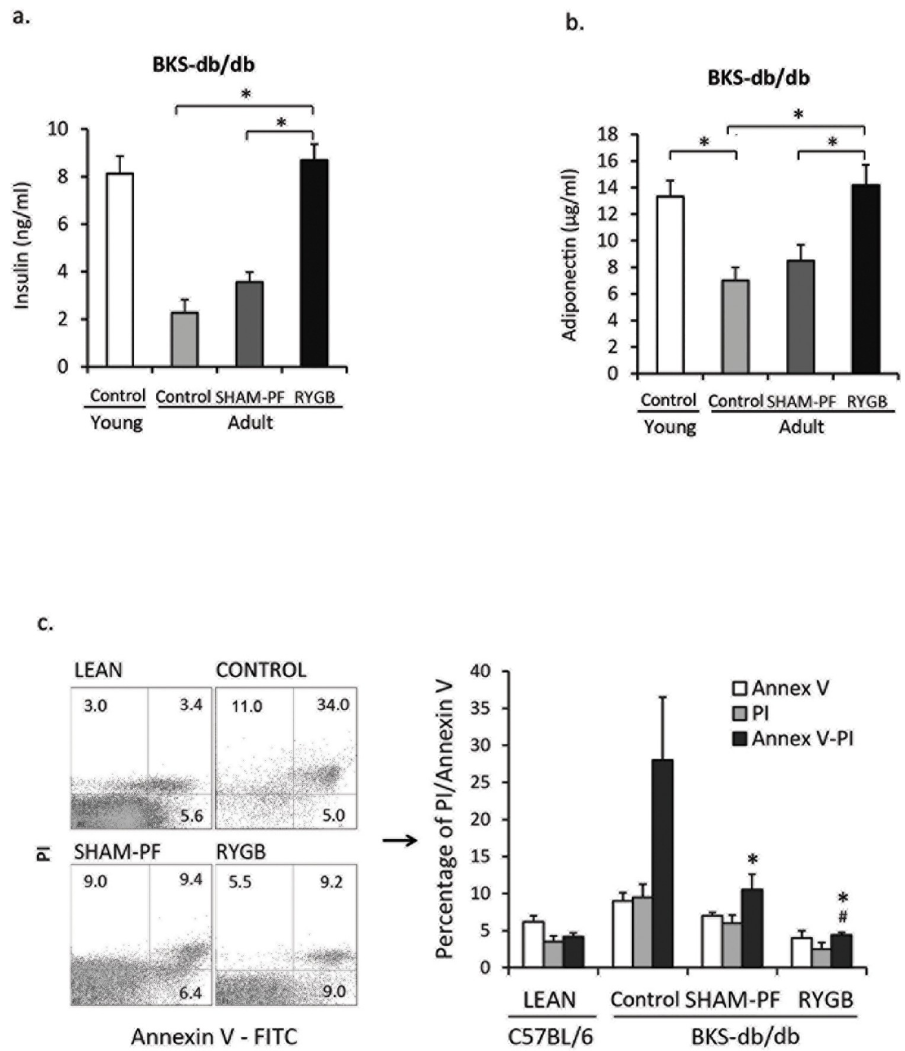
Fig 3. RYGB maintains circulating insulin and adiponectin levels, preserves β -cell mass and prevents β -cell apoptosis when performed in young prediabetic BKS-db/db mice. a. Circulating insulin levels. Young BKS-db/db mice (6 weeks old, n = 5); Adult BKS-db/db mice (12 weeks old, n = 5); SHAM-PF, sham surgery and pair-feeding (n = 5); and RYGB, BKS-db/db mice with RYGB at 6 weeks of age (N = 8). � : RYGB vs. SHAM-PF and Adult Control, p < 0.01. b. Circulating adiponectin levels. � : Young BKS-db/db vs. Adult BKS-db/db, and RYGB vs. SHAM-PF and Adult Control, p < 0.01. c. Annexin V flow cytometry analysis of apoptotic β -cells. LEAN, C57BL/6 mice; CONTROL adult BKS-db/db mice; SHAM-PF, BKS-db/db mice with sham surgery and pair-feeding, and RYGB, BKS-db/db mice with RYGB 4 weeks after surgery (n = 4 in each group). PI, propidium iodide positive; Annex-PI, Annexin V and PI double positive islet cells. � : SHAM-PF and RYGB vs. Control, p < 0.001; and # : RYGB vs. SHAM-PF, p < 0.01.